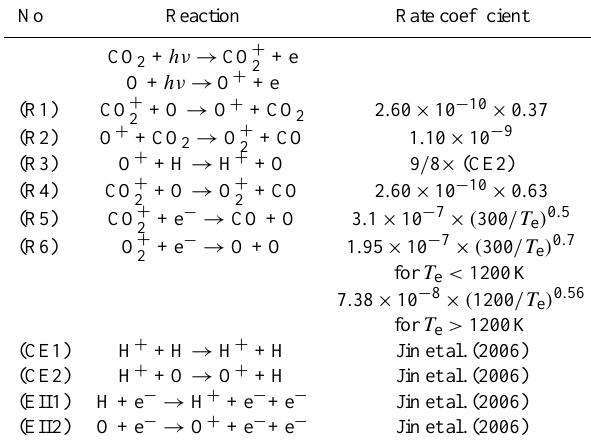
Units are cm 3 s − 1 . The reaction coefficients for the ion-neutral charge exchange (Reactions R1, R2 and R4) were taken from Ani- cich (1993), those for the recombination (Reactions R5 and R6) were taken from Schunk and Nagy (2000) and those for the proton- neutral charge exchange (Reactions CE1 and CE2) and for the elec- tron impact ionization (Reactions EII1 and EII2) were taken from Jin et al.